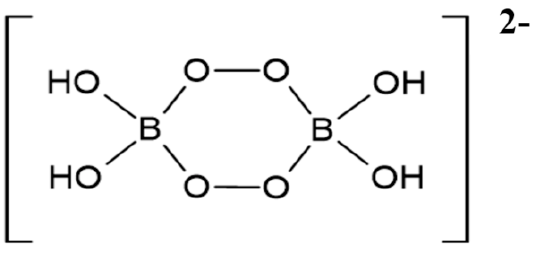
Figure 1. Dimeric structure of the 1,4-diboratetroxane dianion (Structure I).